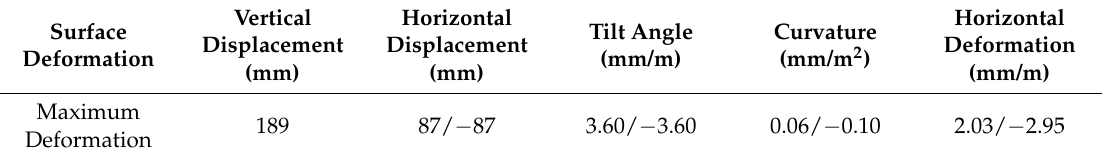
Table 13. Surface deformation after filling with the high-concentration filling